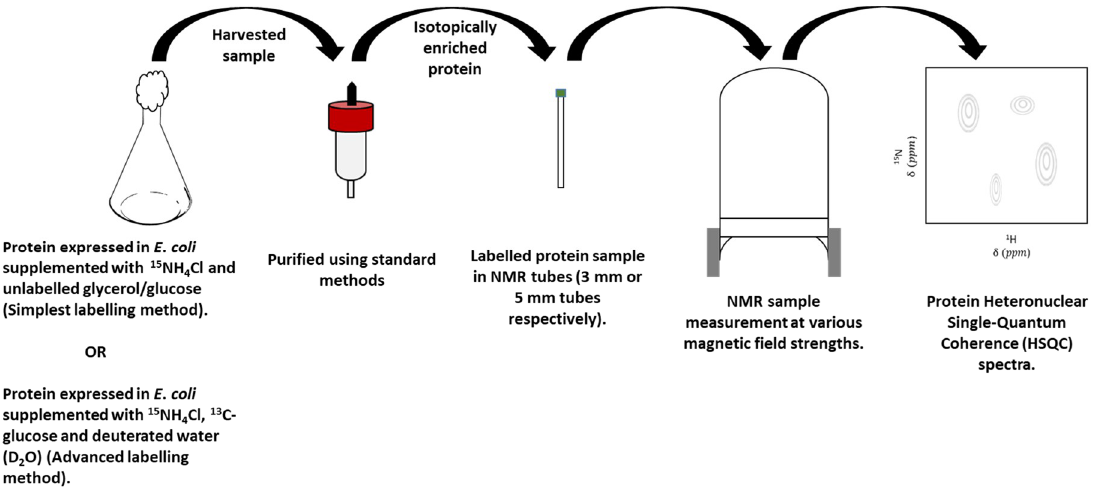
Figure 4. A schematic depicting the bacterial production of recombinant isotopically labelled protein, and recording of an NMR spectrum. and recording of an NMR